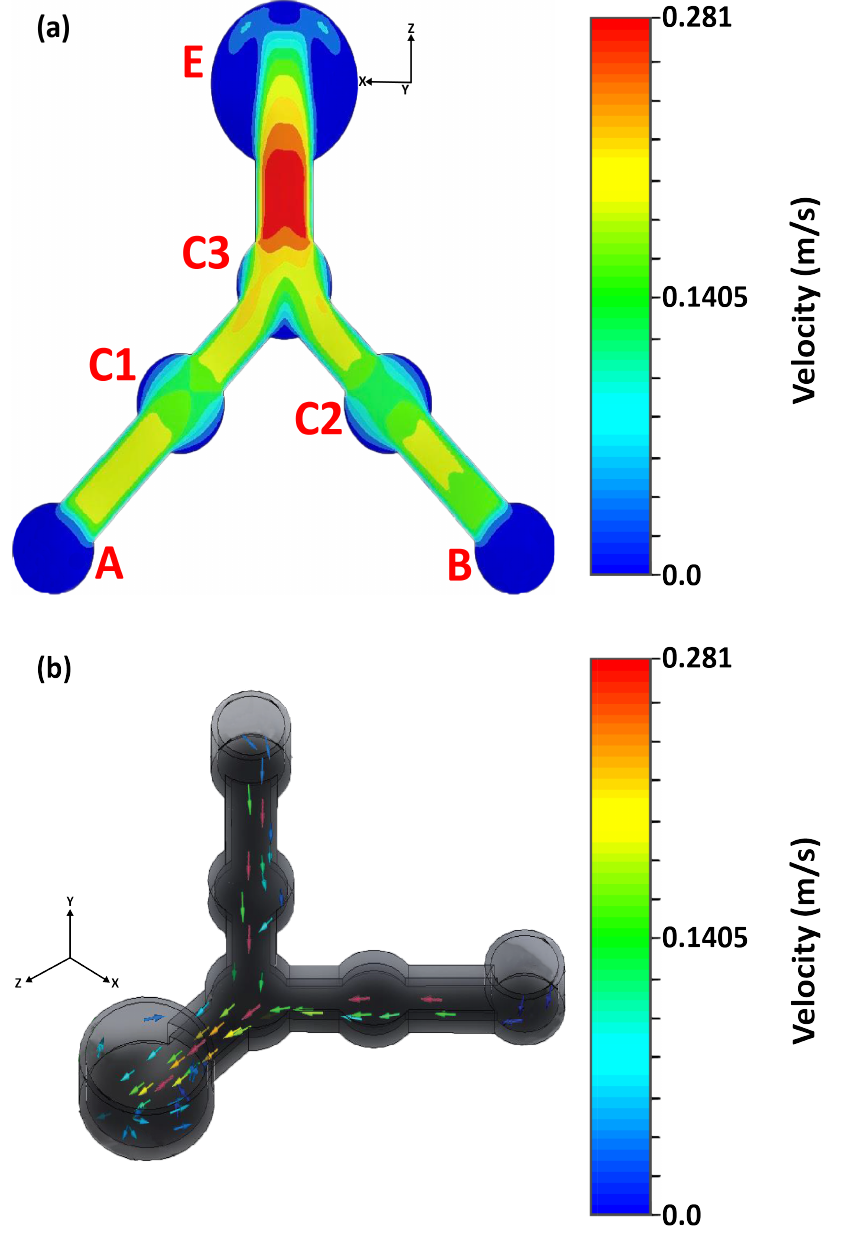
Figure 5. ( a ) Contour image of velocity field of two multi-phases pH 4 and 10 buffer solutions for the 100 µ m microchannels. ( b ) Isometric three-dimensional flow dynamics of distributed charged particles through the microchannels